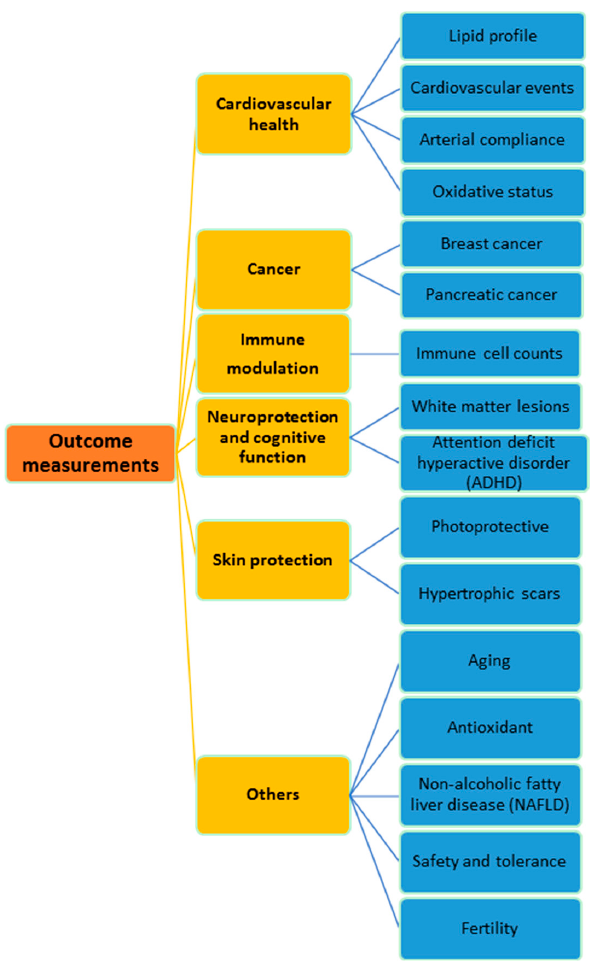
Figure 2. Summary of outcome measurements in tocotrienols clinical studies categorized based on their functionalities.